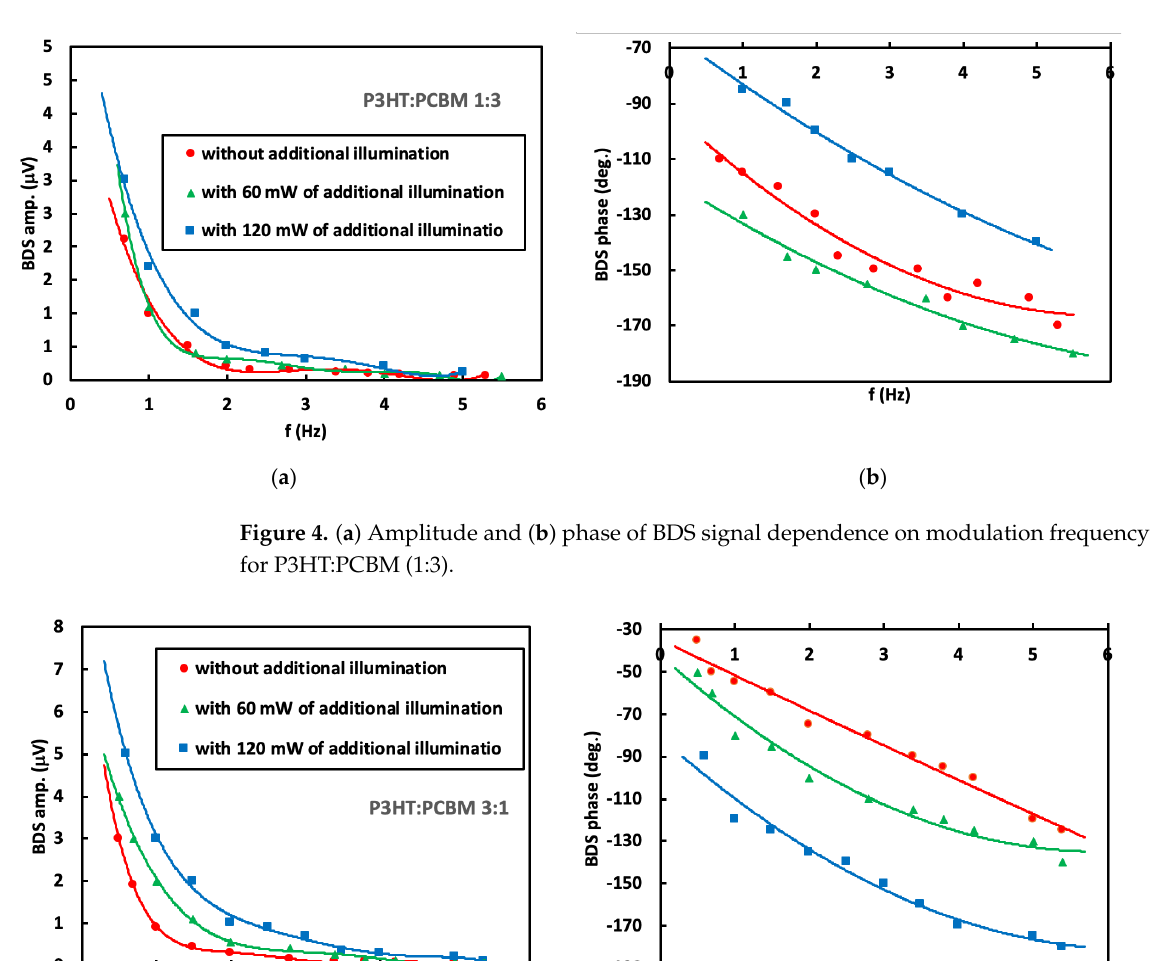
Figure 3. ( a ) Amplitude and ( b ) phase of BDS signal dependence on modulation frequency of TOs for P3HT:PCBM (1:1).